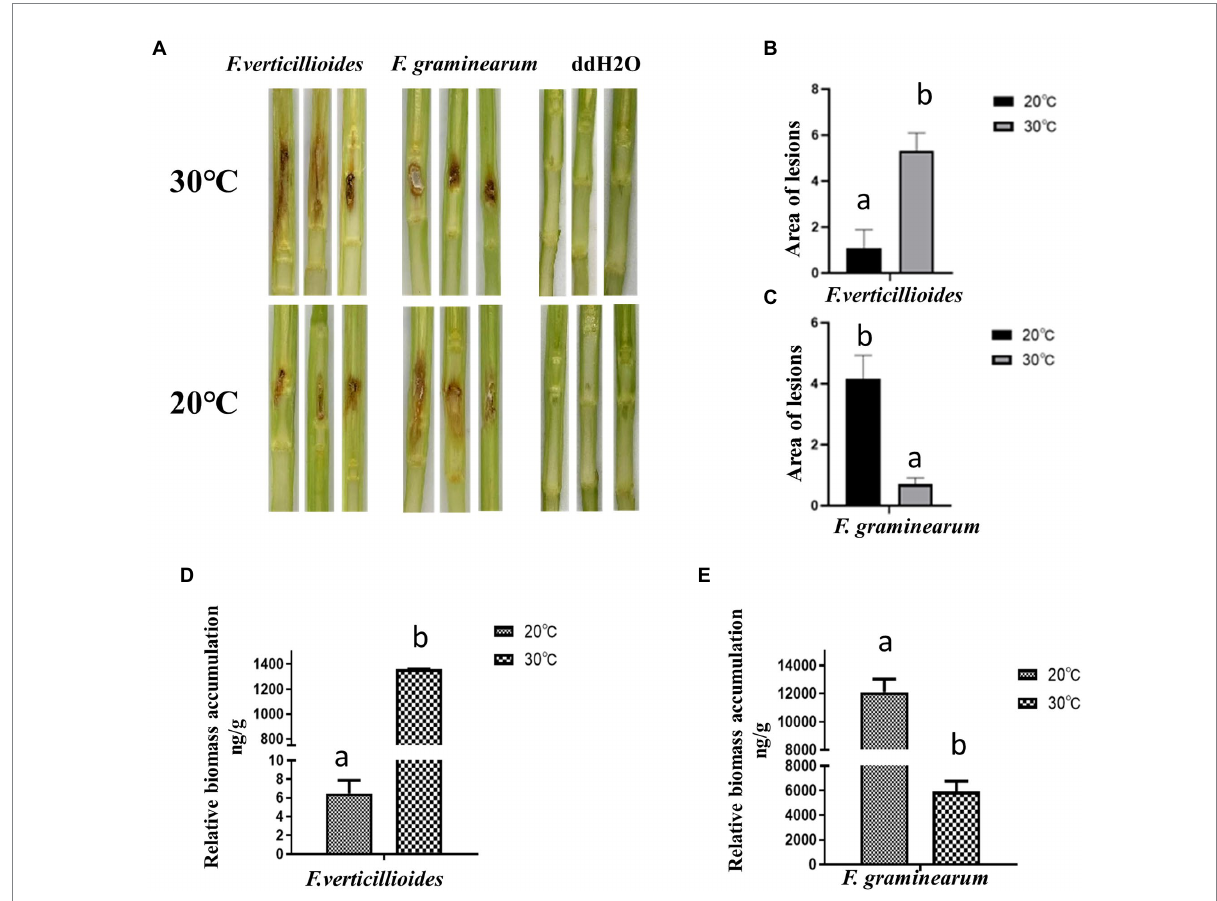
FIGURE 2 The effect of culturing temperatures on pathogenicity of F. verticillioides and F. graminearum. (A) Representative phenotypes of maize stems inoculated with conidial suspensions of F. verticillioides and F. graminearum. Maize stems were inoculated with sterile water as control. Photos were taken 4 d after inoculation; The areas of the lesions caused by F. verticillioides (B) and F. graminearum (C) were measured. The biomass of maize kernels infected with conidial suspensions of F. verticillioides (D) and F. graminearum (E) were measured. Values are means, with standard error bars (n = 3). Columns with non-matching letters indicate a significant difference at p <